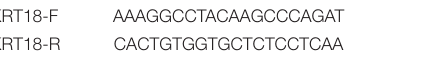
TABLE 2 | Primer sequences of KRT18 expression assessment used in RT-qPCR